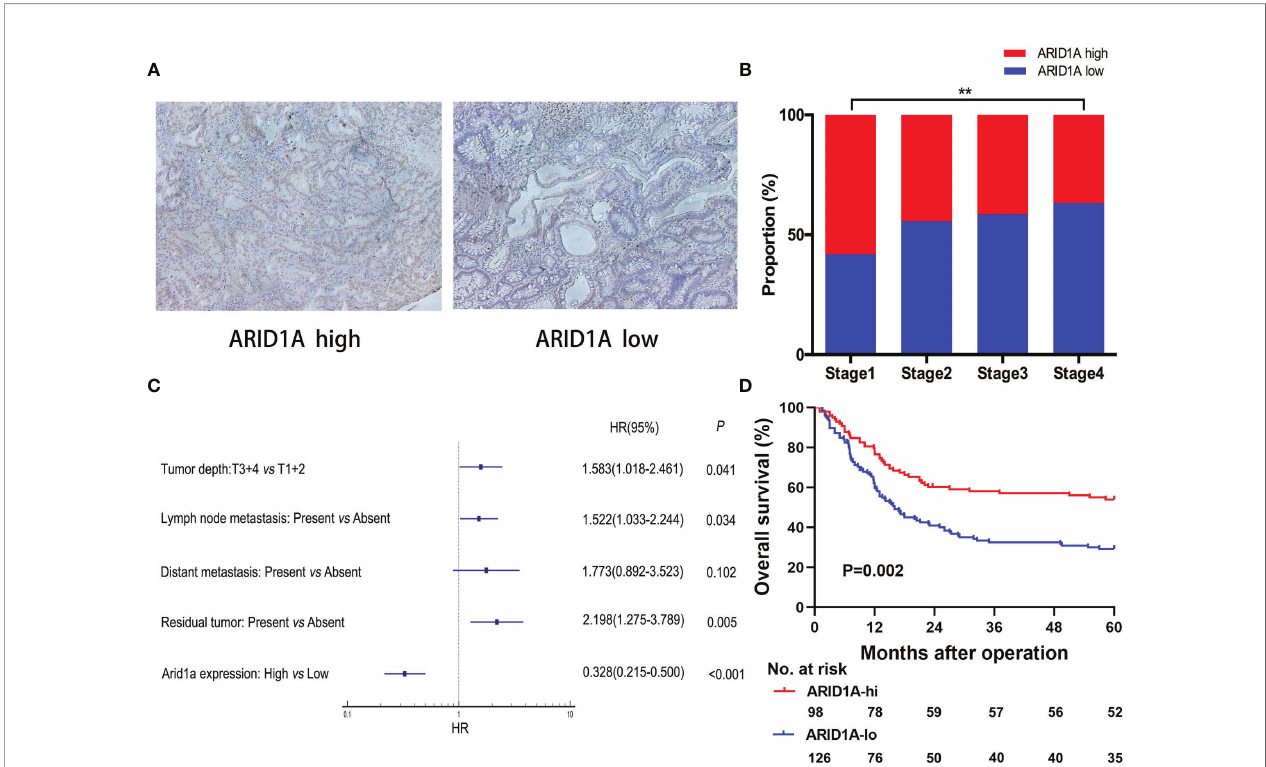
FIGURE 1 | Evaluation of AT-rich interactive domain 1A (ARID1A) expression by immunohistochemical staining in patients with gallbladder cancer (GBC). (A) Representative immunohistochemical images of tumor tissues with high or low ARID1A expression. (B) Proportions of different TNM stages in patients with high or low ARID1A expression. (C) Multivariate Cox regression analysis identi fi ed ARID1A expression as an independent prognostic factor for overall survival. (D) Kaplan – Meier survival analysis of overall survival in all patients. **P <